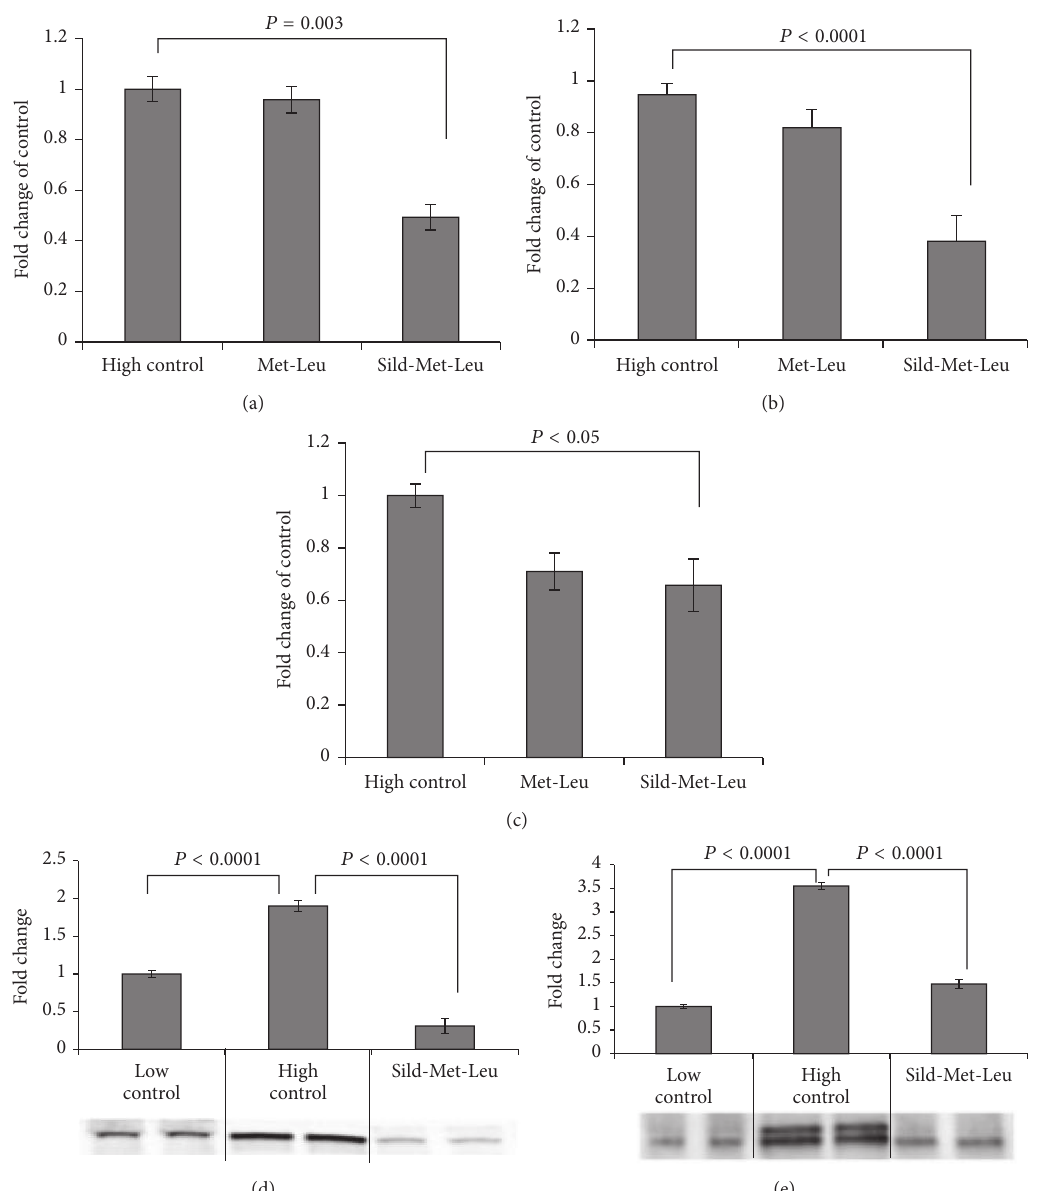
Figure 2: Sild-Met-Leu treatment in hepatocytes decreases lipogenic gene expression. HepG2 cells were treated with sildenafil (Sild, 1 nM), metformin (Met, 0.1mM), and leucine (Leu, 0.5 mM) as indicated for 24 hours after induction of lipid accumulation and compared to nontreatedcellsafterlipidaccumulation(highcontrol)orwithoutlipidaccumulation(lowcontrol). (a)Fattyacidsynthase(FAS),(b)stearoyl- coenzyme A desaturase 1 (SCD1), and (c) acetyl-coenzyme A carboxylase 1 alpha (ACC 1 alpha) gene expression were measured. Data are presented as mean ± SEM ( 𝑛 = 8 to 12). ((d) and (e)) Protein expression of FAS and SCD1: quantitative data, presented as mean ± SEM, and representative blots are shown ( 𝑛 = 4